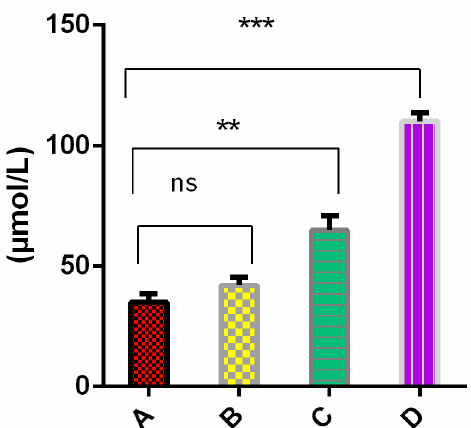
Figure 6. Lactate dehydrogenase assay of N2a cell incubated with tau aggregates treated with 2 or tau aggregates alone for 24 h, then the supernatant tested. Data are represented as mean and SD and analyzed through one-way ANOVA and Dunnett’s multiple comparison test ( p < 0.05). Non-significant (ns), significant (**), (***). The red, yellow, green, and purple bars represent control (monomers), treated aggregates, aggregates alone, and lysis buffer, respectively.